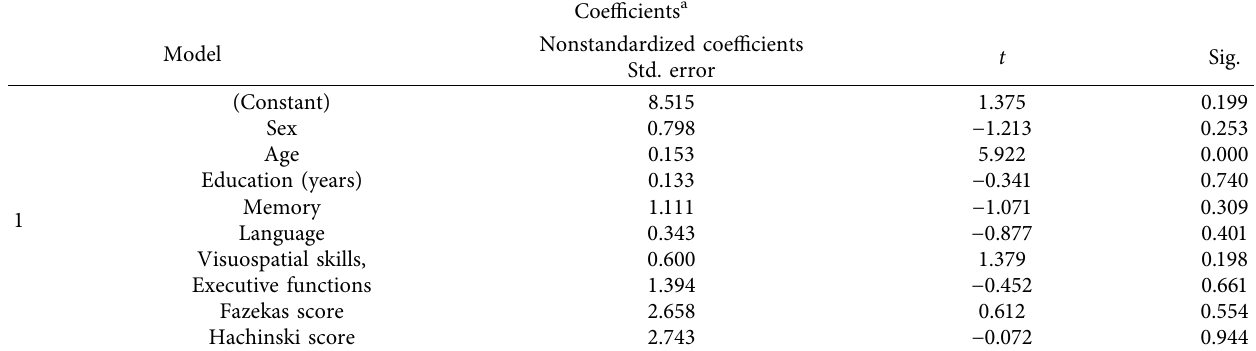
Figure 6: Flow chart of the research. Table 1: Coefficient values for